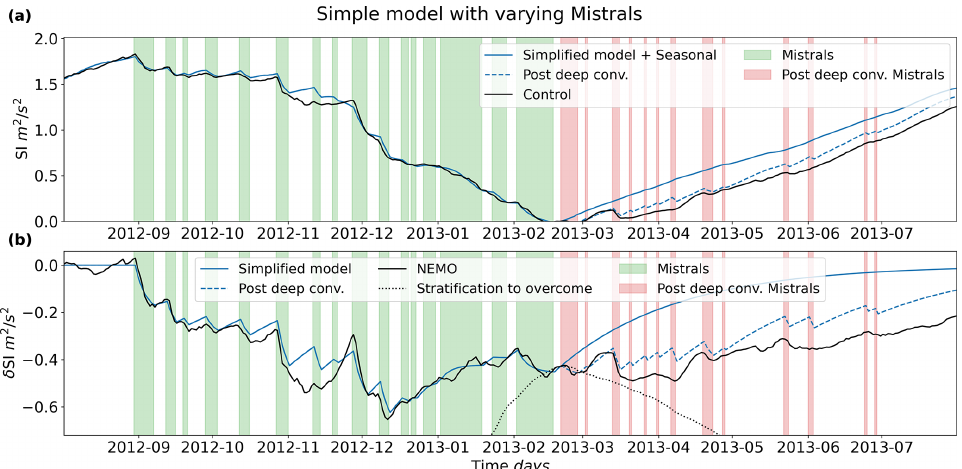
Figure 14. The combined effect of Eq. (17) for multiple mistrals with the mistral data from Tables 1 and A1. Panel (a) shows the calculated δ SI + SI S response, while (b) is the calculated simple model δ SI vs. the NEMO δ SI simulation results. Effects from mistrals after deep convection are included with the dashed blue line and show that mistrals after deep convection can retard the proceeding restratification during the restratification